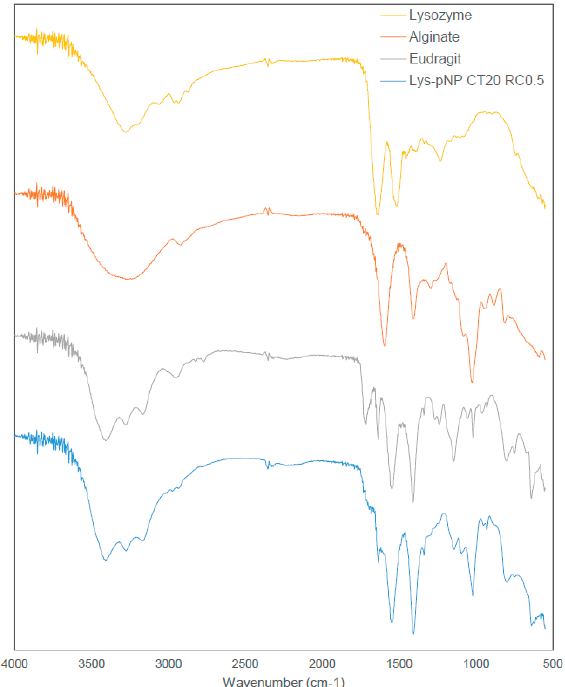
Figure 2. FTIR Spectra of pure materials and Lys-loaded pNP CT 20 and RC 0.5 showing characteristic peaks of each separate material and no evidence of covalent interactions among Lys and materials, supporting the electrostatic interactions that sustain the polymeric system.